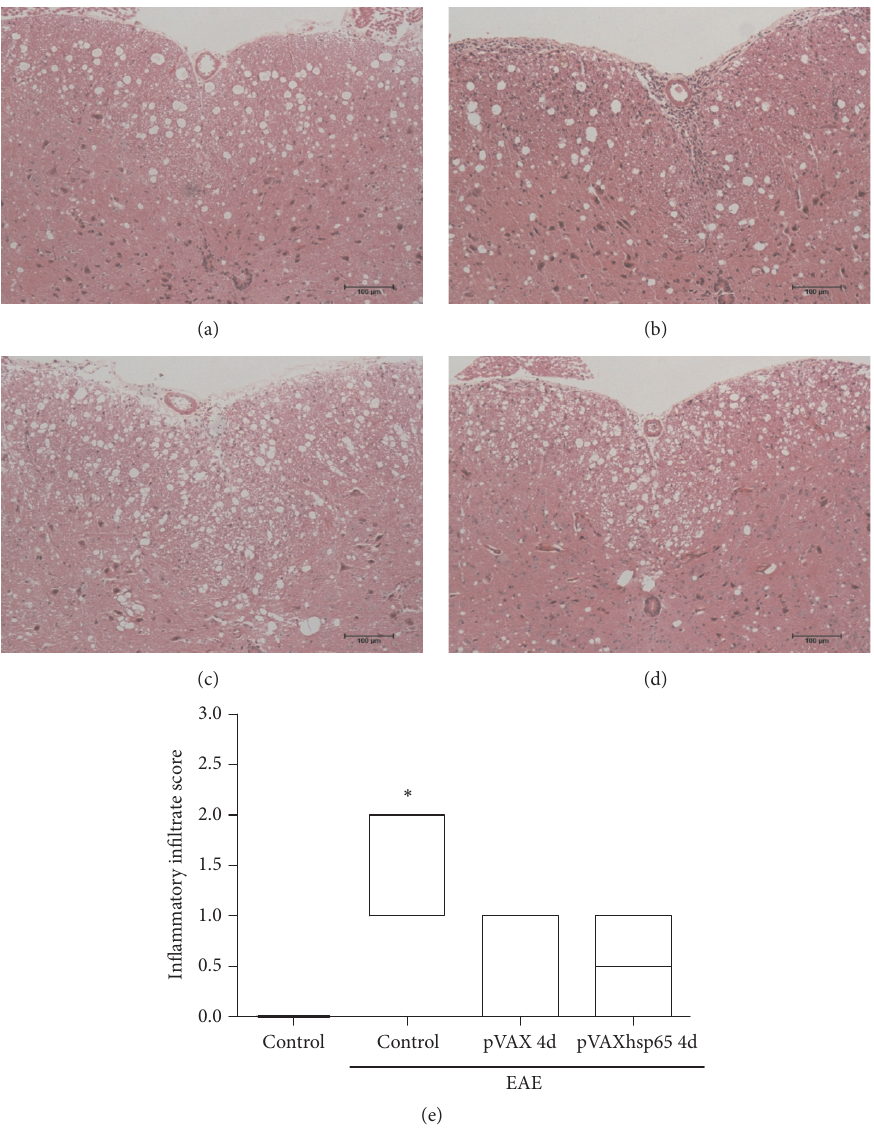
Figure 3: Effect of previous immunization with pVAXhsp65 on CNS inflammation . C57BL/6 mice were immunized with 4 pVAXhsp65 doses and then submitted to EAE induction. Lumbar spinal cord inflammatory infiltrates in control mice without EAE (a), control mice with EAE (b), and mice immunized with 4 pVAX (c) or pVAXhsp65 doses (d) were evaluated 30 days after EAE induction. A semiquantitative analysis was used to assess the inflammatory infiltration (e) during the chronic disease phase. Micrographs are representative of 6 animals/group. Data in panel (e) were presented by mean ± SE of 6 mice. ∗ represents the difference between immunized and control group with EAE. 𝑝 < 0.05